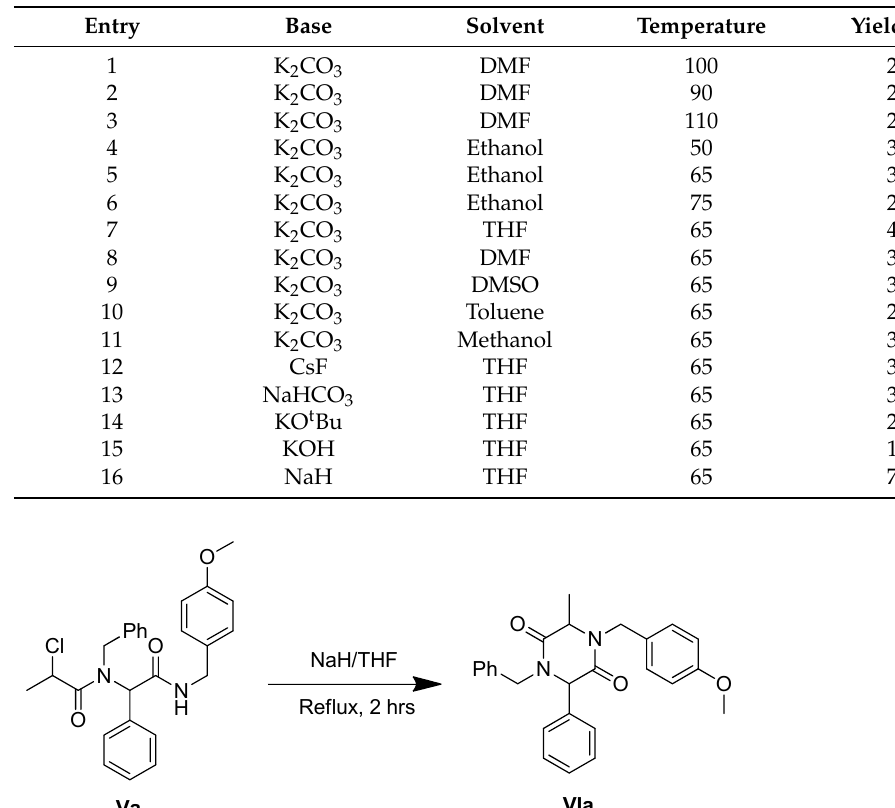
Table 2. Optimization for model cyclisation reaction.